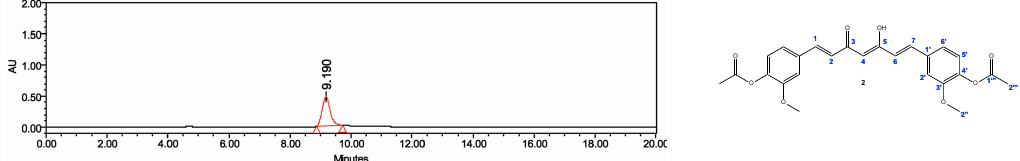
Figure 5. Chromatogram of curcumin (1) (t R = 4.873 min) sample, injected at a concentration of 0.25 mg/ml, with detection at a wavelength of 265 nm.